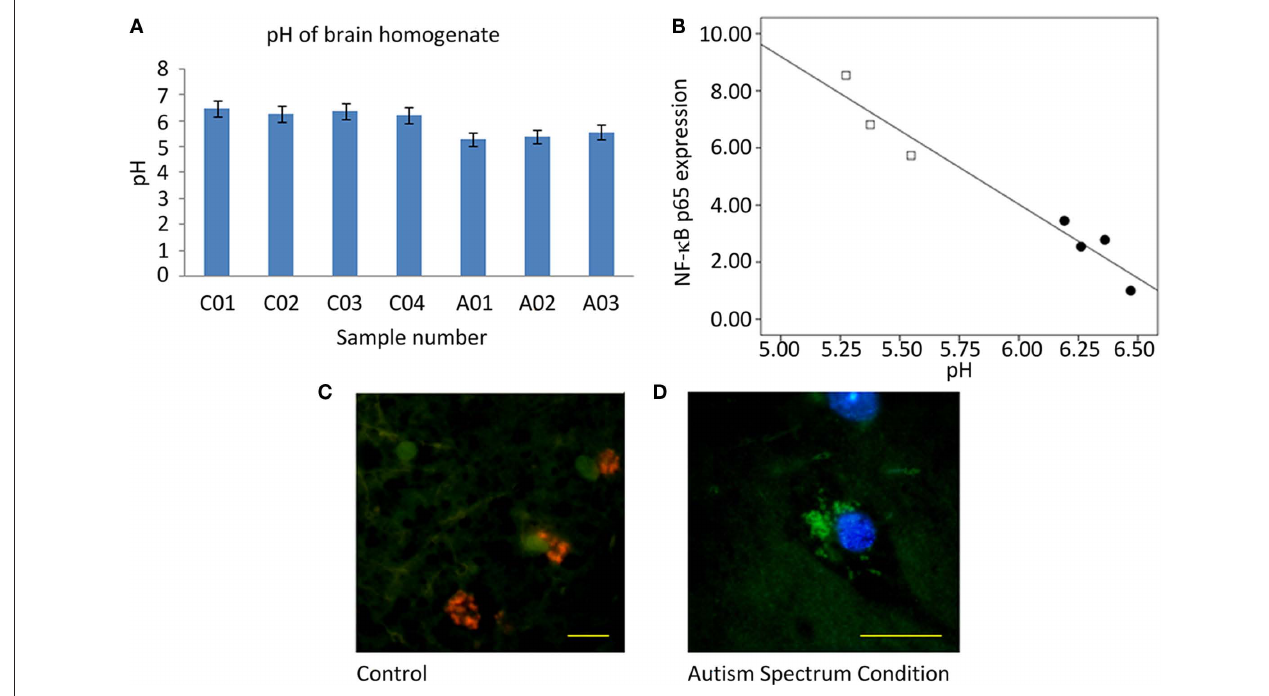
image from a tissue sample from control donor ( × 63 objective, scale bar = 20 μm) and (D) from a sample from ASC donor ( × 100 objective, scale bar = 20 μm). Images are pseudocolored and show the ratio of acridine orange/ Lysotracker Red fluorescence. Green hues represent low lysomic pH, and red hues represent high lysomic